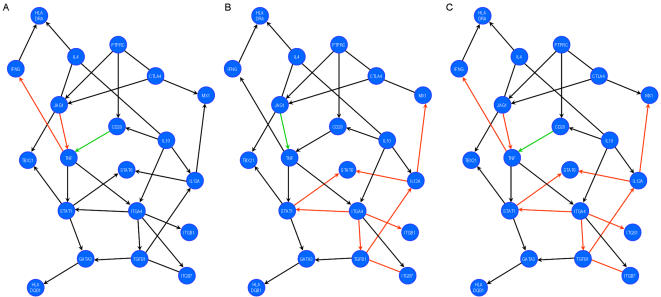
Comparison of the T-cell activation network after in vitro stimulation with jagged1, IFN-ß or Jagged1+IFN-ß:A) untreated patients versus stimulation with the Jagged1 agonistic peptide for 24 h; B) untreated patients versus stimulation with IFN-B for 24 h; C) untreated patients versus stimulation with JGA1+IFN- ß for 24 h. Comparisons between gene interaction weights are described using the following colour code: black: no change; green: decreased; red: increased. See Table 5 for statistical analysis.